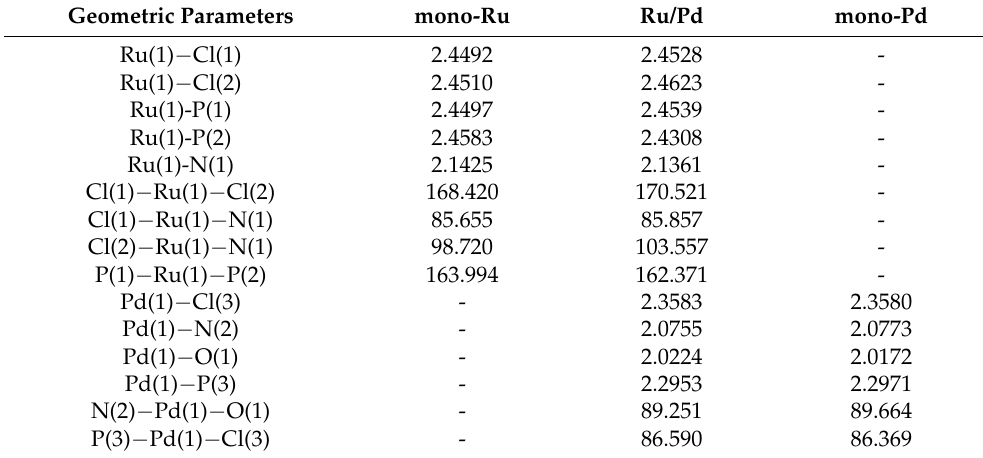
Table 1. Theoretical bond distances (Å) and bond angles ( ◦ ) for mono-Ru, mono-Pd, and Ru/Pd. Geometric